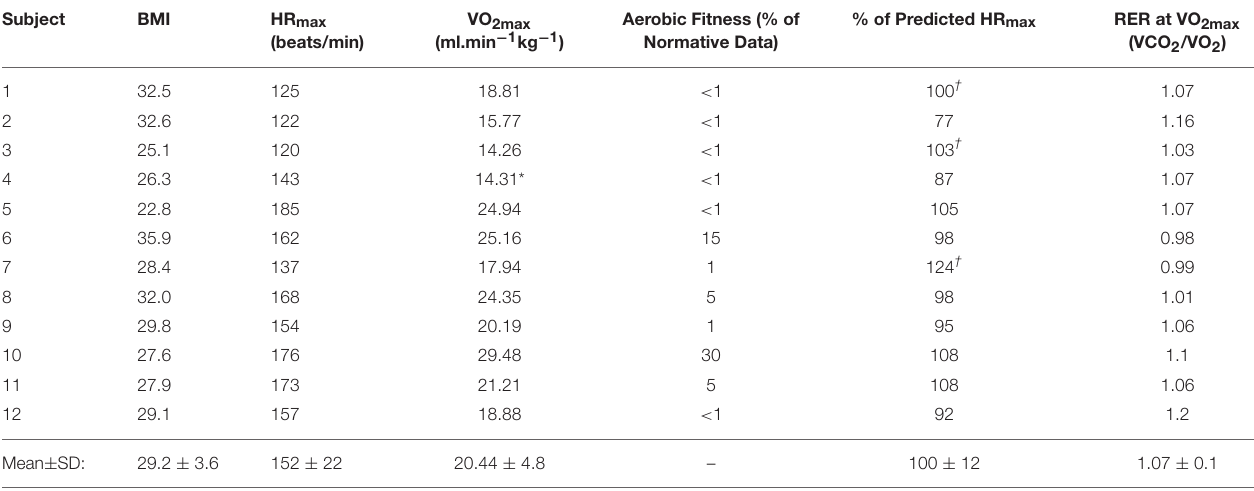
TABLE 2 | Fitness profile of participants.